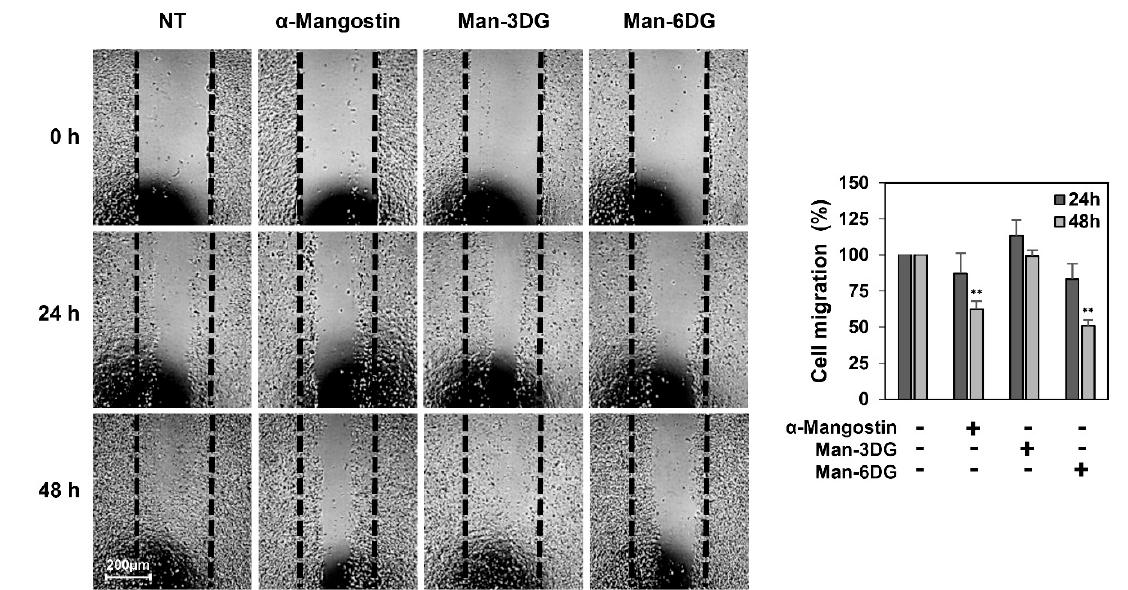
Figure 3. The effects of α -mangostin glycosides on the migration of Hep3B cells by a wound-healing assay. The cells were incubated in the absence or presence of α -mangostin, Man-3DG, and Man-6DG (10 µ M) for 48 h. The cells that migrated into the gap were counted using an optical microscope. The dotted black lines indicate the edge of the gap at 0 h. Each value represents the mean ± SD from three independent experiments. ** p < 0.01 versus the control.